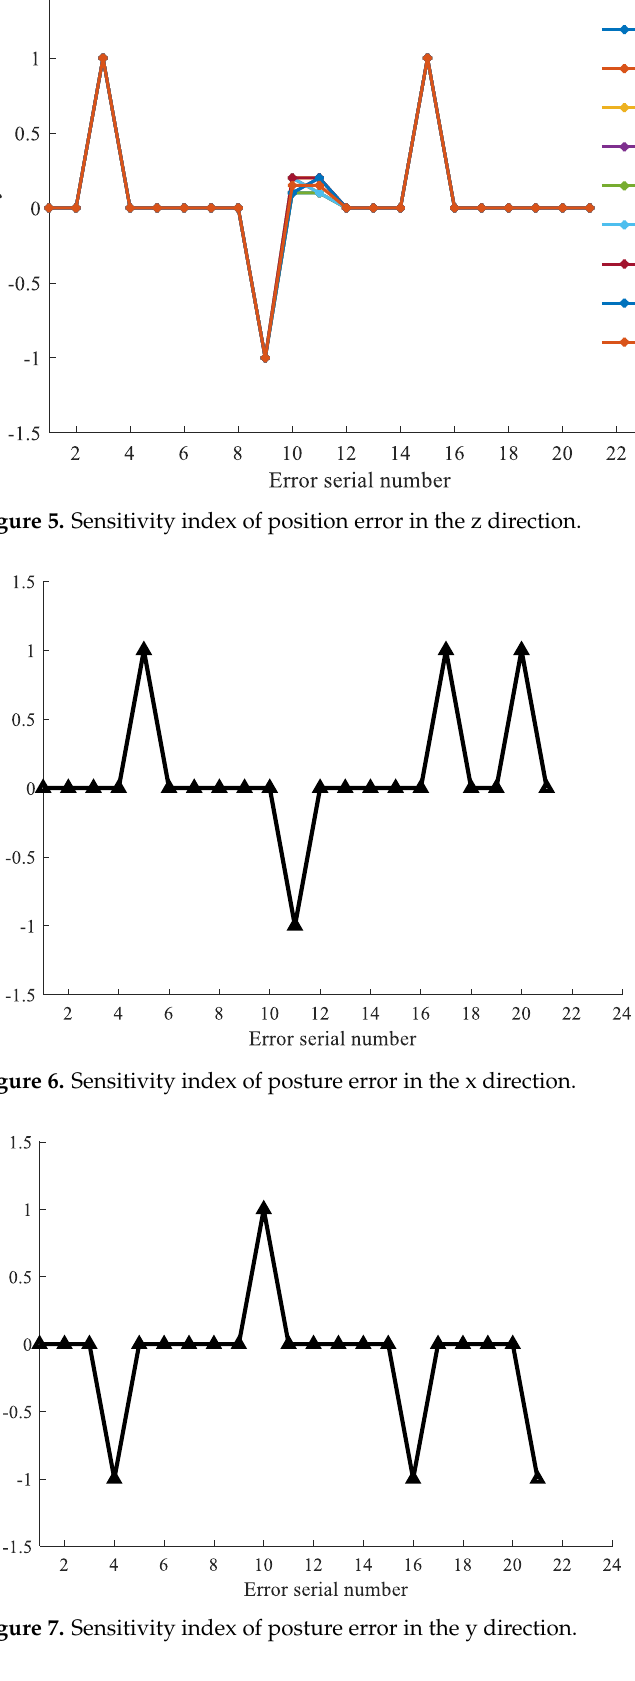
Figure 7. Sensitivity index of posture error in the y direction.